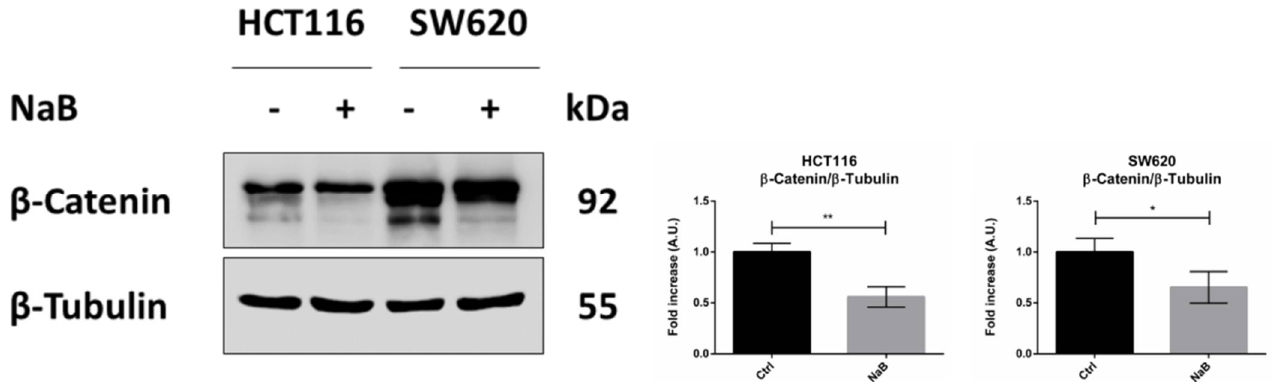
Figure 5. Sodium butyrate decreases β-Catenin cellular content. HCT116 and SW620 cells were incubated with 2 mM NaB for 48h. Medium was replaced and substances re-added at 24h to avoid possible starvation effects. Cell homogenates were analyzed by Western blotting for the expression of β-Catenin. The filter was re-probed with β-Tubulin as a loading control. The blot is representative of three experiments with reproducible data; band densitometry is shown in the panel. The graphs represent the average ± SD (significance was considered as follow: * p < 0.05, ** p < 0.01).